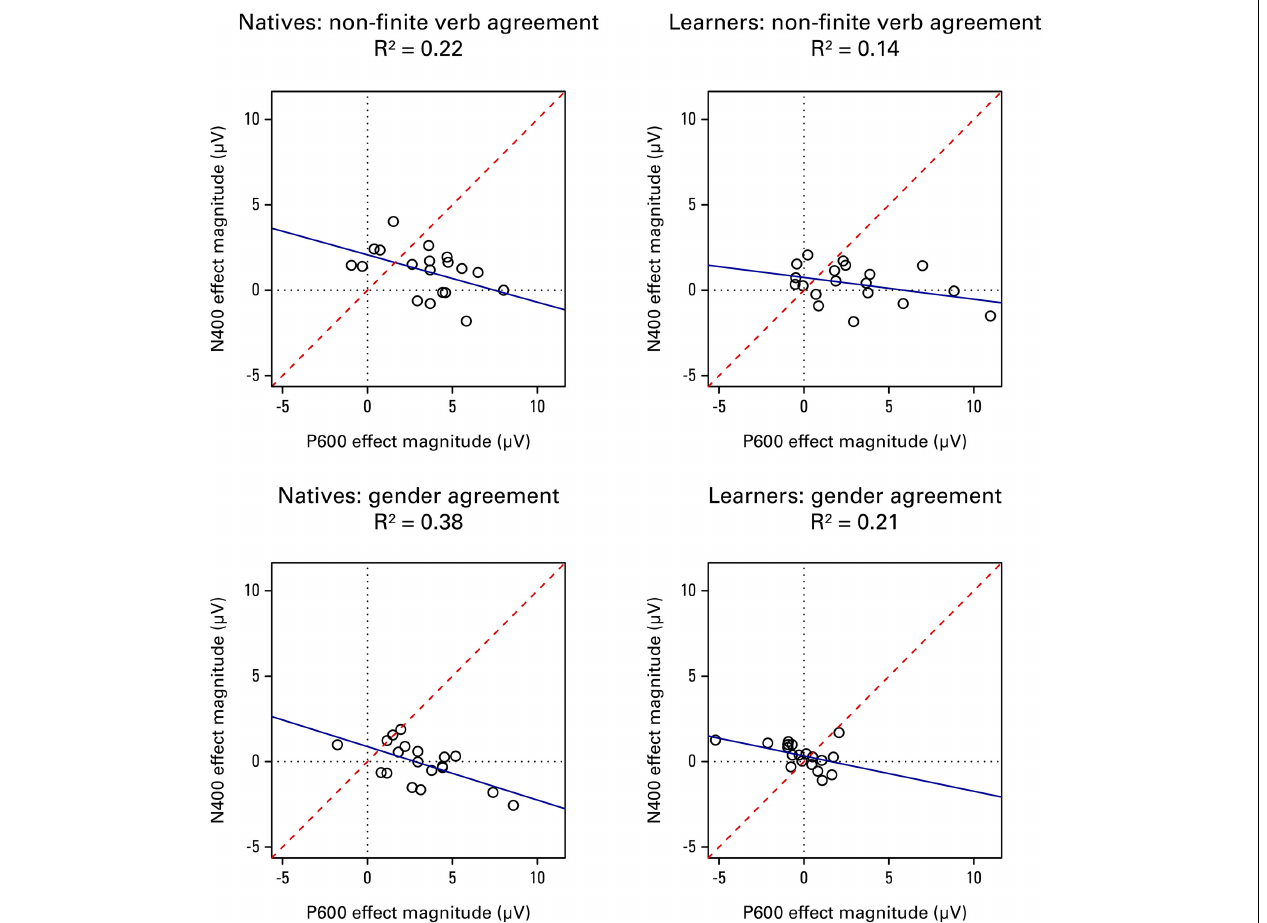
FIGURE 6 | The distribution of N400 and P600 effect magnitudes (correct minus incorrect for N400, incorrect minus correct for P600) across learners, averaged within middle frontal and all temporal, parietal, and occipital ROIs. Each dot represents a data point from a single participant. The solid line shows the best-fit regression line. The dashed line represents equal N400 and P600 effect magnitudes: individuals above/to the left of the dashed line showed primarily an N400